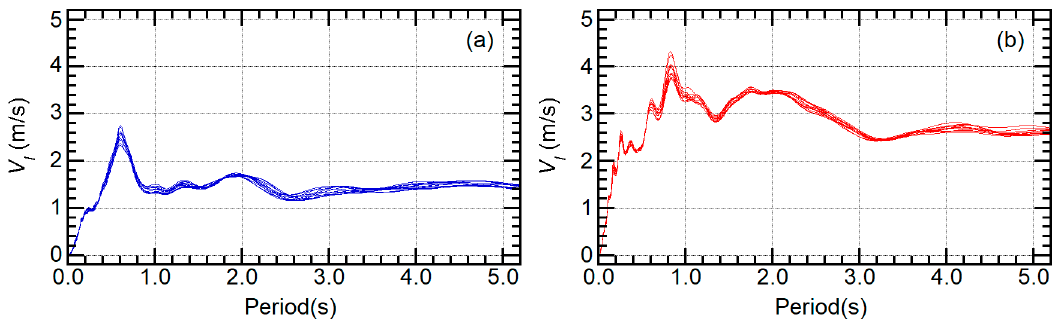
Figure 9. Elastic V I spectrum of the generated artificial ground motions: ( a ) Art-S Series; ( b ) Art-L Series.